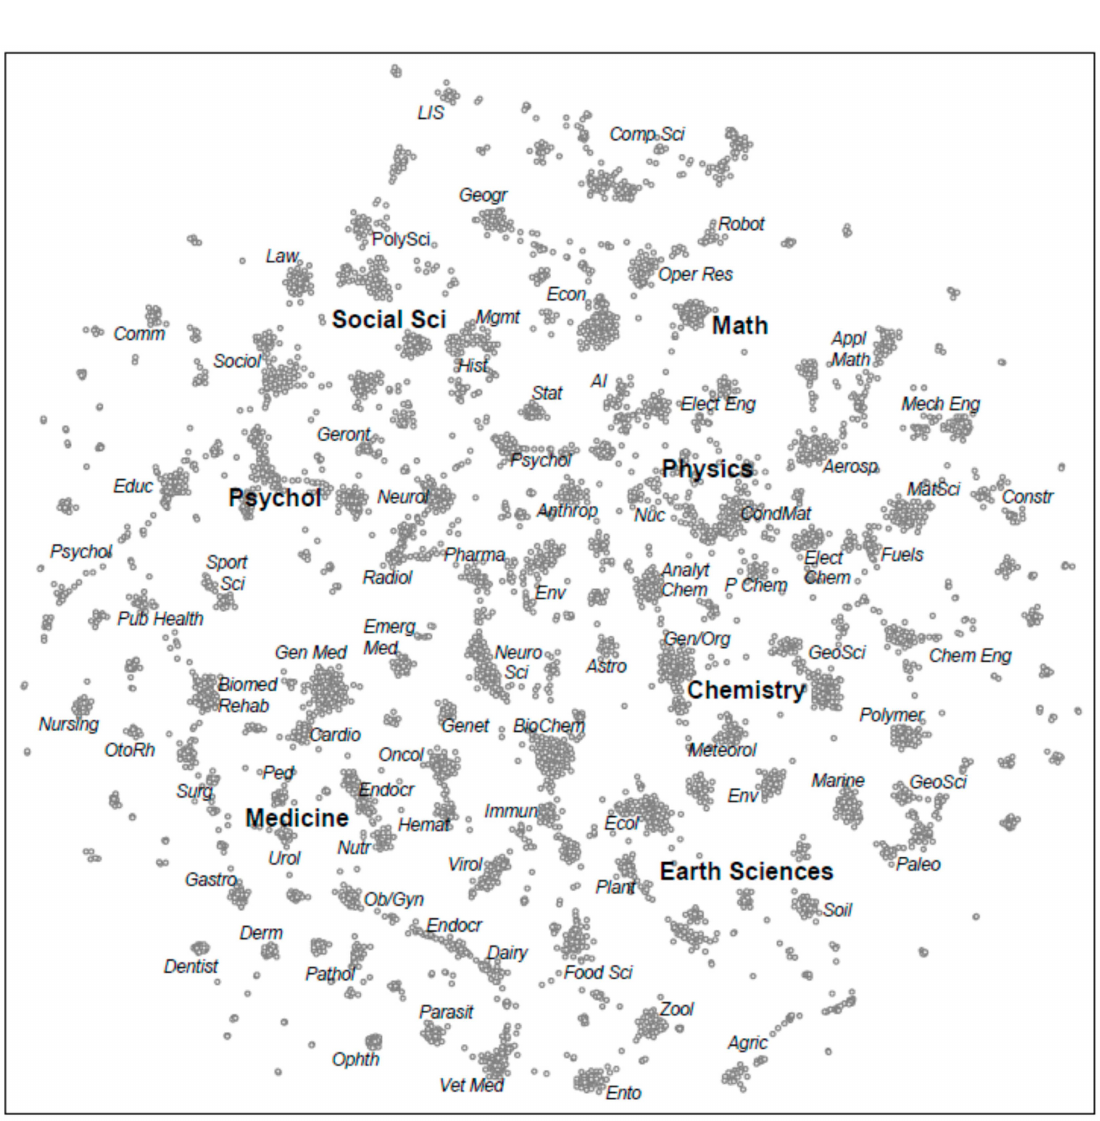
Figure 9. Maps of science showing clusters of journal-journal relatedness for major areas of science. Smaller labels denote the disciplinary topics of nearby large clusters of journals. (From [36]; reprinted by permission of